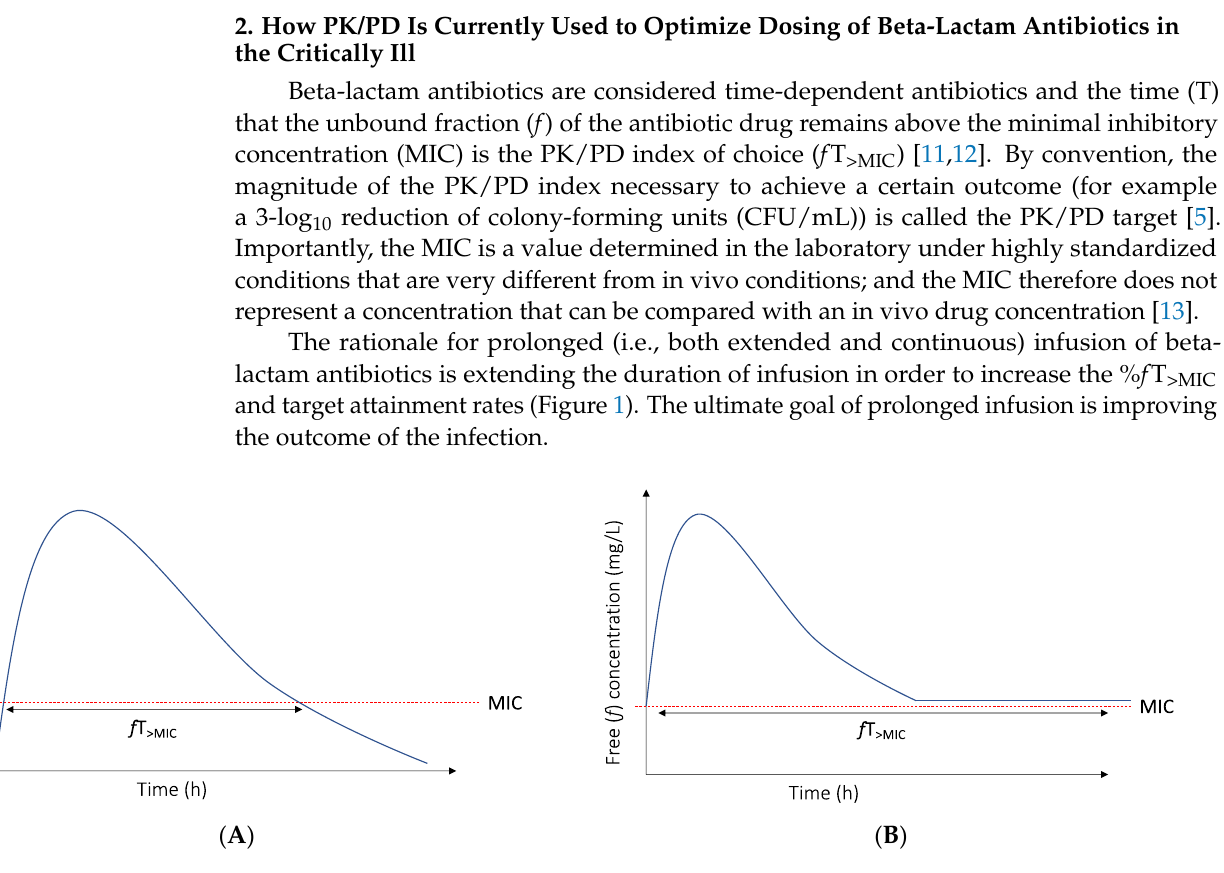
Figure 1. Time above the MIC for intermittent ( A ) and continuous ( B ) infusion with initial